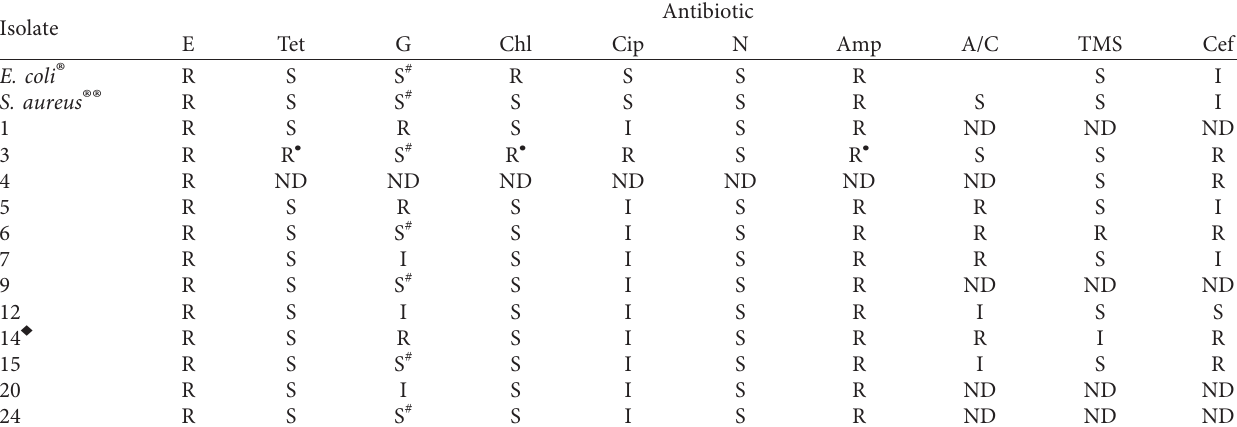
Table 4: Antibiotic disk diffusion sensitivity test results.